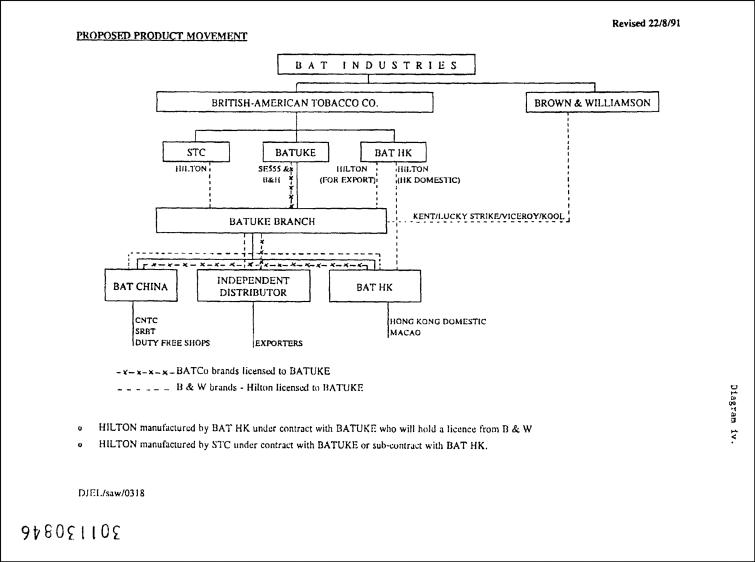
Planned Restructuring of BAT Operations to Separate Supply of “Independent Distributors” to ChinaSource: British American Tobacco Documents Archive. Available:
http://bat.library.ucsf.edu/pageview?a=img&tid=fm41a99&total=2. Accessed 19 June 2006.